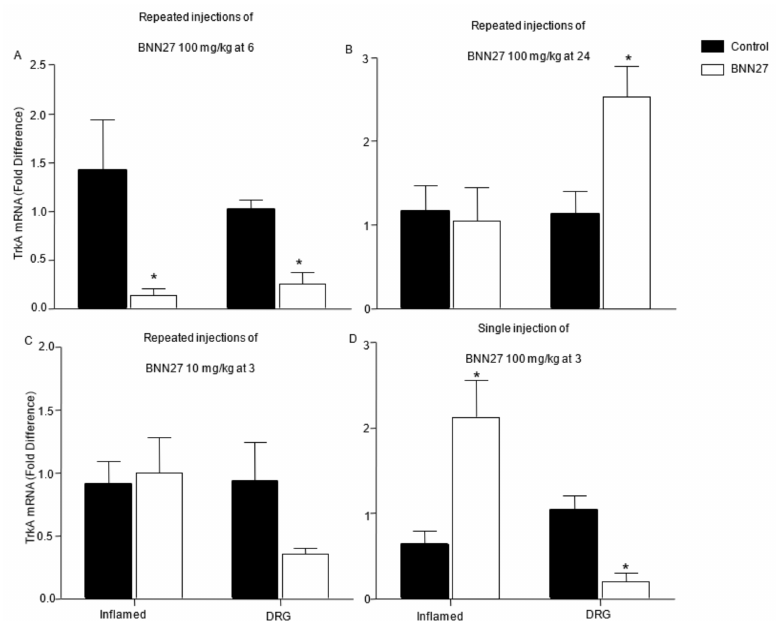
Figure 10. Effect of BNN27 on the expression of TrKA in the inflamed paw and DRG. Repeated injections of 100 mg/kg of BNN27 decreased the TrkA mRNA levels in the inflamed paw and DRG at 6 h ( A ), while at 24 h BNN27 had no effect on paw TrkA mRNA whereas it increased its expression in DRG ( B ). Repeated injections of 10 mg/kg of BNN27 did not induce any significant changes in the TrkA mRNA levels in the inflamed paw and DRG ( C ). Single treatment with 100 mg/kg of BNN27 increased paw TrkA mRNA levels while in DRG, the same dose decreased TrkA mRNA levels ( D ). ( A ) Inflamed paw: Control n = 4 mice, BNN27-treated group n = 4 mice; DRG: Control n = 4 mice, BNN27-treated group n = 4 mice. ( B ) Inflamed paw: Control n = 4 mice, BNN27-treated group n = 5 mice; DRG: Control n = 5 mice, BNN27-treated group n = 4 mice. ( C ) Inflamed paw: Control n = 6 mice, BNN27-treated group n = 5 mice; DRG: Control n = 6 mice, BNN27-treated group n = 5 mice. ( D ) Inflamed paw: Control n = 4 mice, BNN27-treated group n = 4 mice; DRG: Control n = 4 mice, BNN27-treated group n = 4 mice. In all figures * p < 0.05. Statistical analysis was performed using unpaired t -tests. All data are expressed as the mean ±